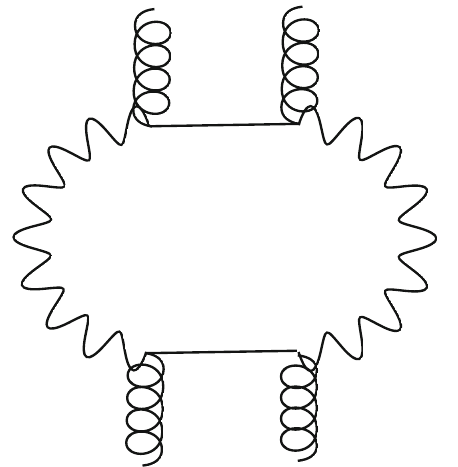
Fig. 4 A diagram for the generated effective